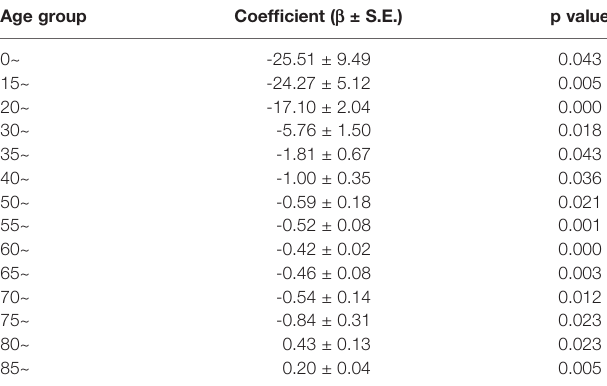
TABLE 3 | The regression trends of HCC incidences in different age groups in Shanghai. Age group